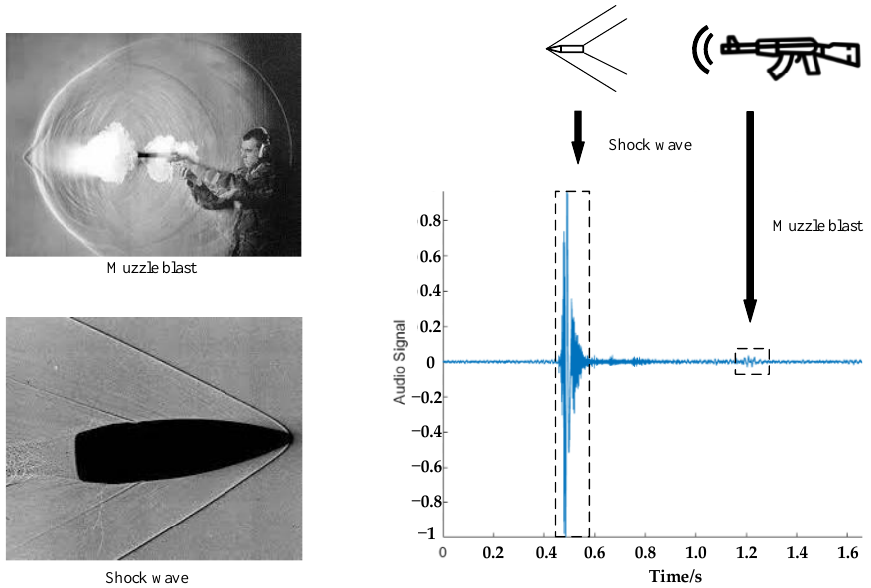
Figure 1. Schematic diagram of a muzzle sound wave.